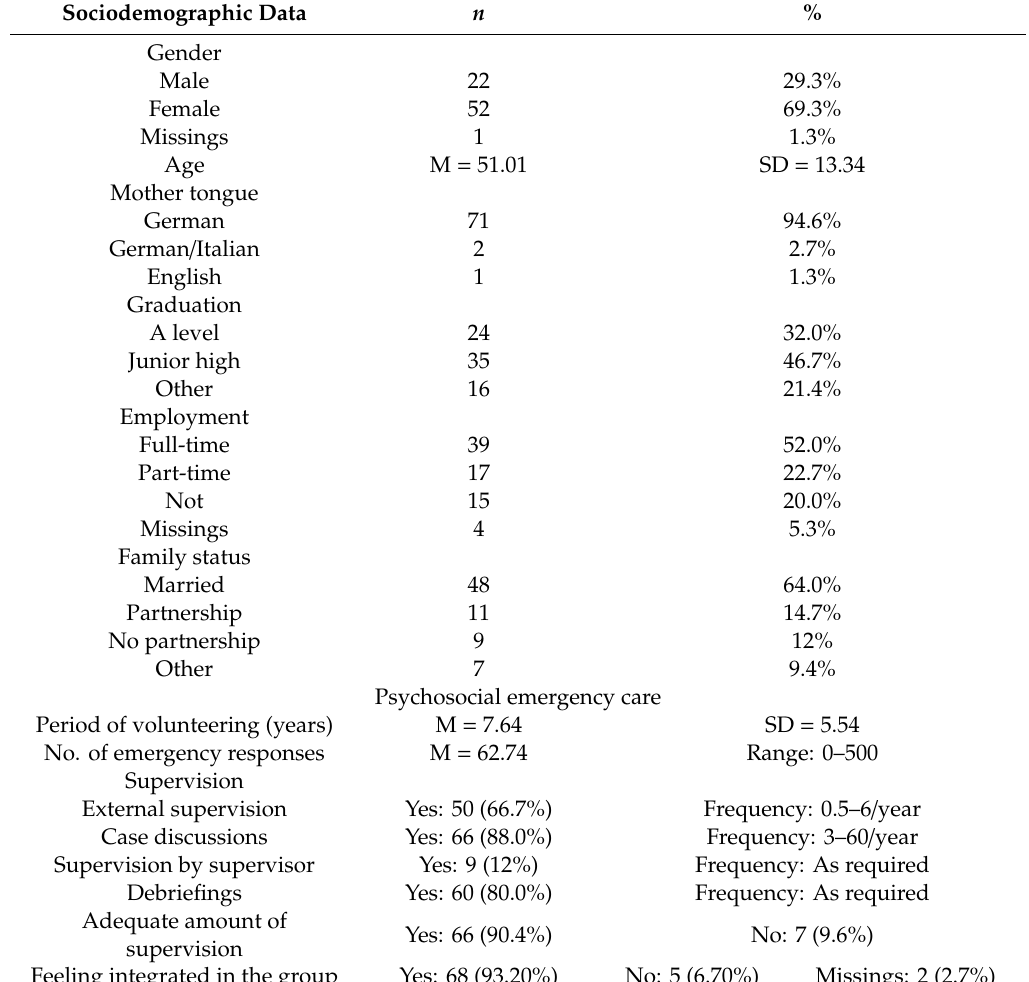
Table 1. Sociodemographic data of volunteers in psychosocial emergency